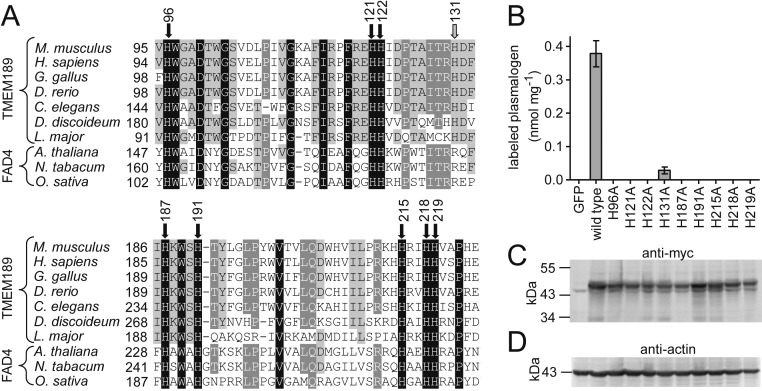
Importance of the eight-histidine motif for plasmalogen formation by transiently expressed TMEM189 protein. (A) Amino acid sequence comparison of pfam10520 motif containing proteins. Two regions containing the conserved histidines are shown. Black arrows indicate histidines conserved in all proteins; gray arrow, histidine conserved in TMEM189 proteins only. Numbers at arrows correspond to the position in the murine TMEM189 protein sequence. (B) Ability of plasmids expressing WT and mutated murine TMEM189 proteins to enable formation of pyrene-labeled plasmalogens on feeding with 1-O-pyrenedecyl-sn glycerol in TMEM189-deficient human HAP1 cells. At 24 h posttransfection with plasmids for TMEM189 proteins containing C-terminal 6x myc tags, cells were fed for another 24 h with 5 µM 1-O-pyrenedecyl-sn-glycerol. A plasmid for GFP served as a control. Values were related to the amount of cellular protein. Data are mean ± SEM of three experiments. (C) Expression of the recombinant proteins was monitored at 48 h posttransfection by Western blot analysis using an antibody against the C-terminal 6x myc tag. A representative example of three independent experiments is shown. (D) Western blots against β-actin to monitor cellular protein loading.